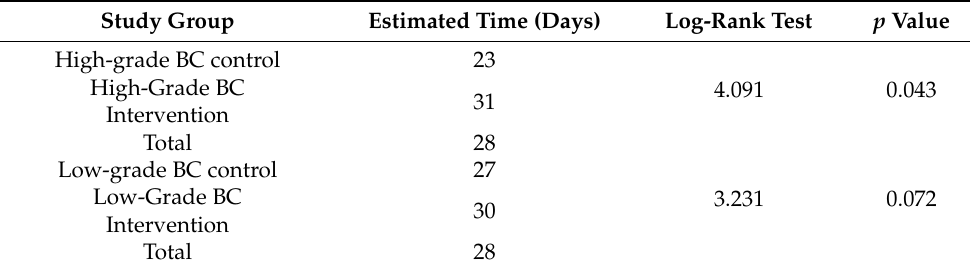
Table 2. Log-rank test for animal survival in control and interventional groups.